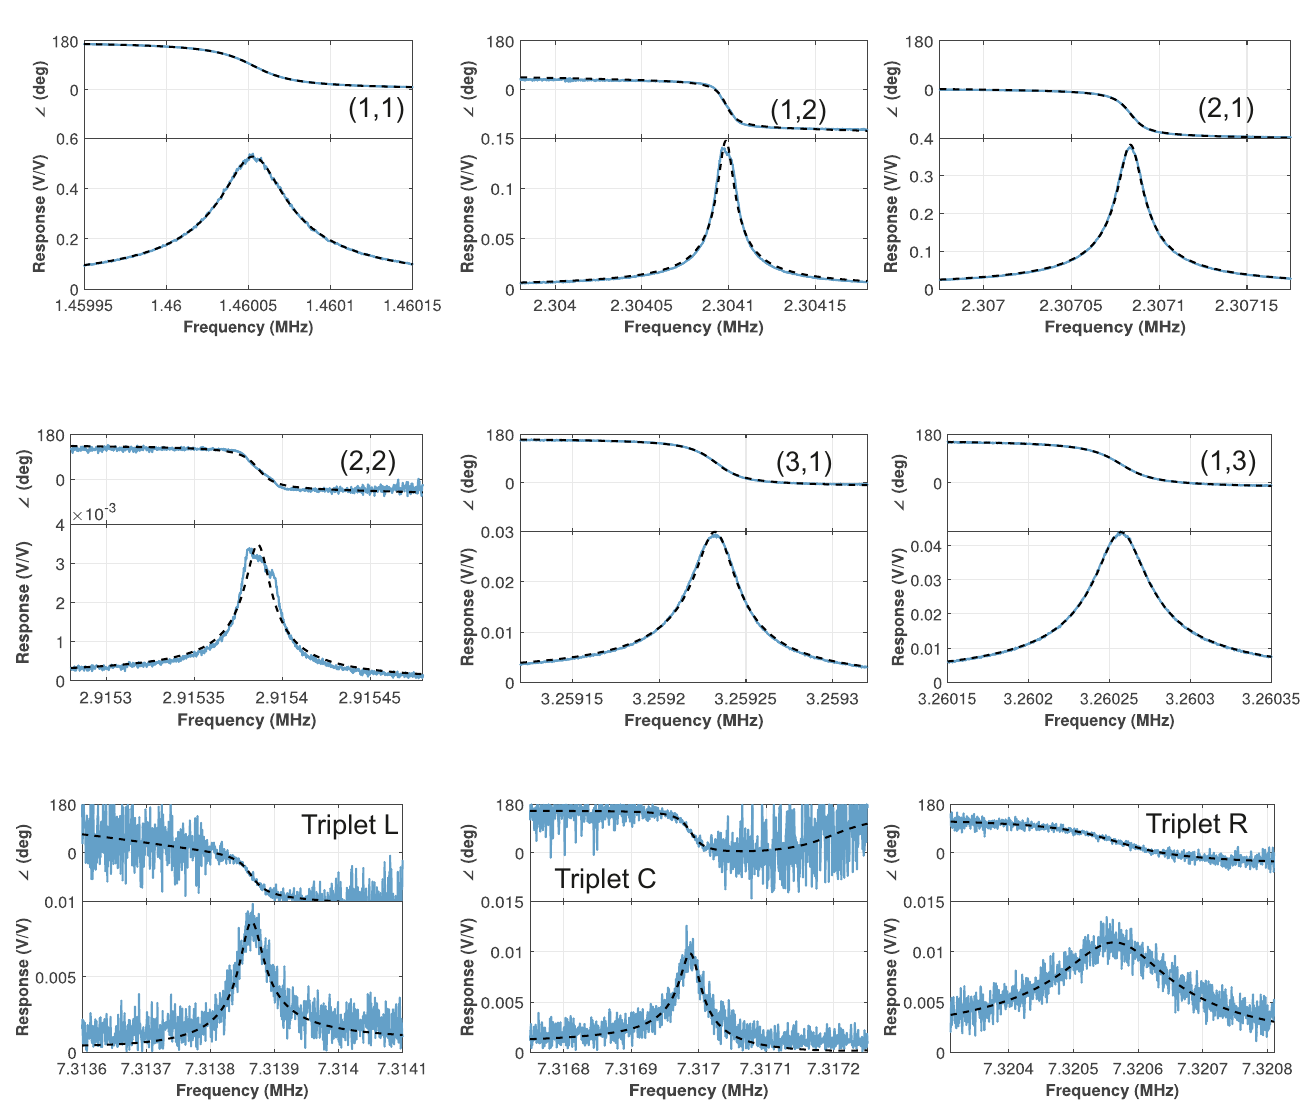
Figure A2. Driven responses of all the modes used in this work. For the first 6 modes, the span is 200 Hz, whereas for the triplet the span is 500 Hz. The gray curves are measured using the LIA, whereas the red curves are the fits of Equation (A1) to the data. The measurement settings and fit results are indicated in Table